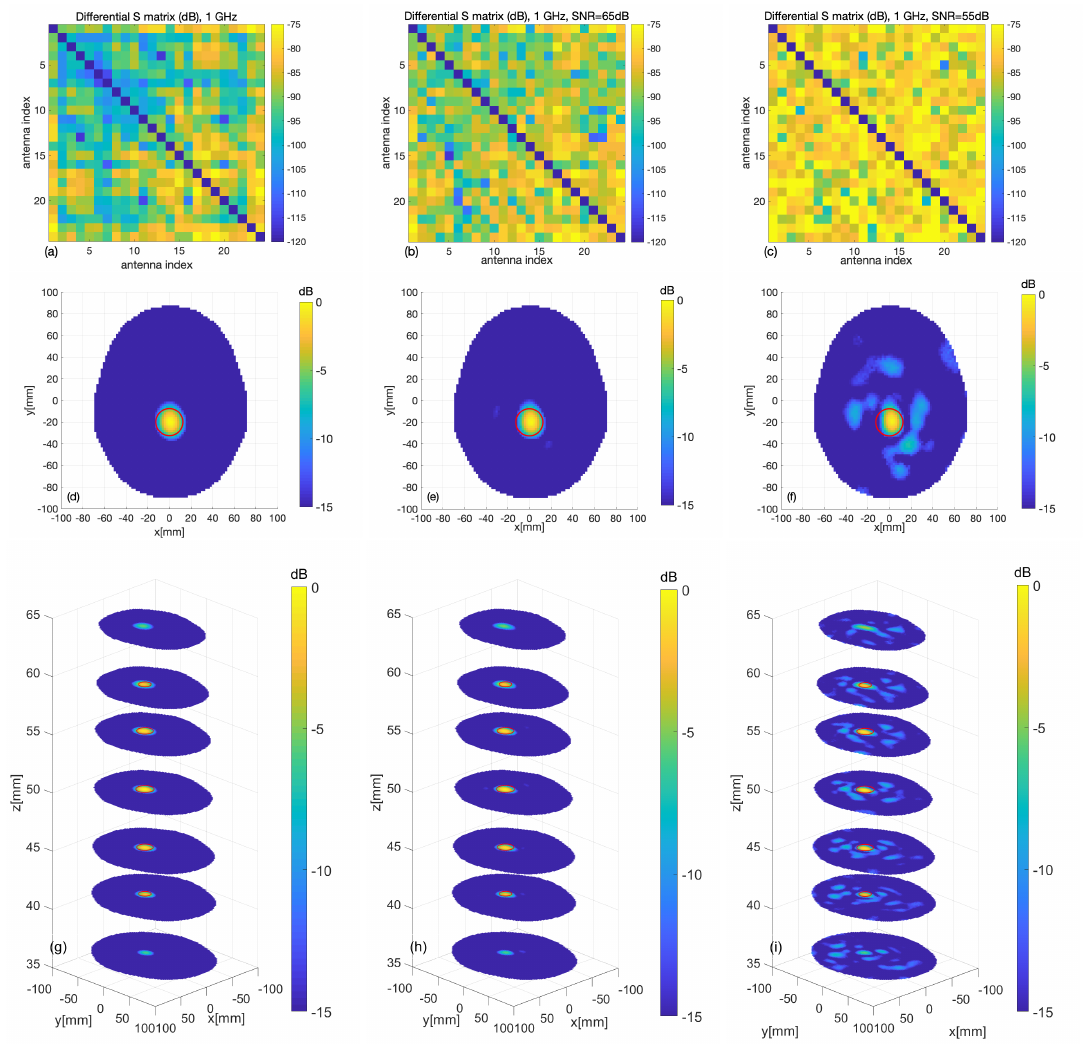
Figure 9. Digital twin: case of a target plastic sphere; the exact sphere location and shape are indicated by red circles; ( a – c ) differential scattering matrices, and ( d – f ) cross-sections of the reconstructed images at the sphere center and ( g – i ) at various levels, for different values of the signal-to-noise ratio (SNR) (left column: no noise, middle column: SNR = 65dB , right column: SNR =